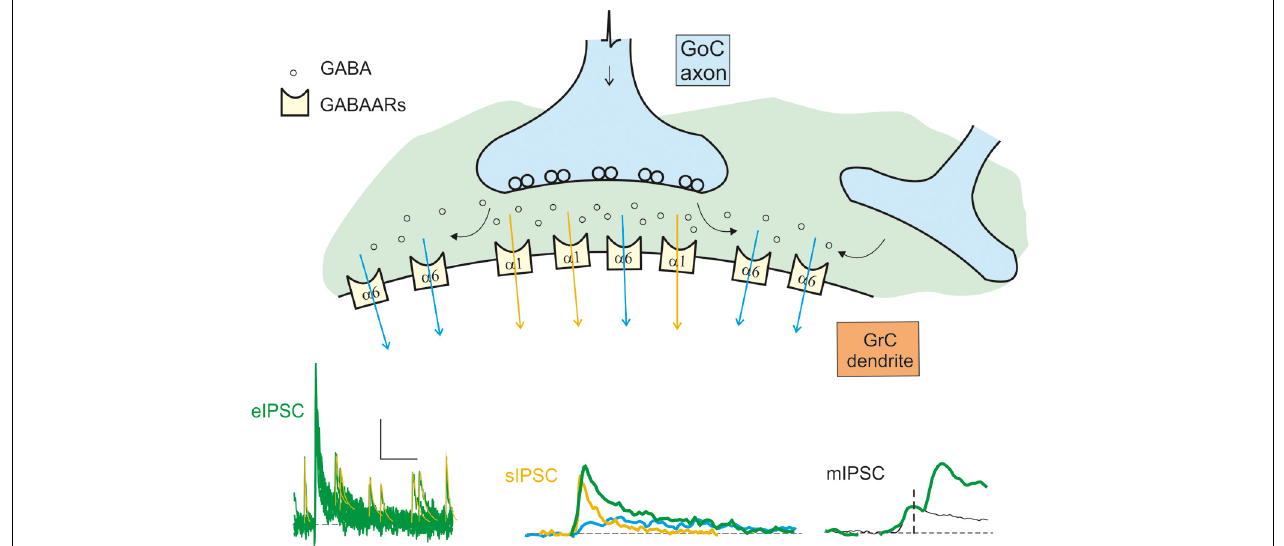
FIGURE 2 | Schematic representation of the origin of the inhibitory currents. The schematic drawing represents the GoC to GrC synapse, illustrating the major components of inhibitory transmission. Depending on whether the α 1 (synaptic) or the α 6 (extrasynaptic) receptors are activated, the current give raise to the direct (fast) or indirect (slow) IPSCs. The distribution of the α 1 and α 6 subunit-containing GABA-A receptors (GABAARs) is indicated. Depending on the combinations of direct and indirect components, miniature (mIPSCs), spontaneous (sIPSCs), and evoked (eIPSCS) IPSCs are generated: